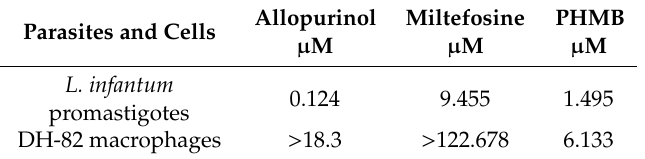
Table 2. IC 50 values for all drugs studied for L. infantum promastigotes and cytotoxicity for DH-82 macrophages. Allopurinol Parasites and Cells